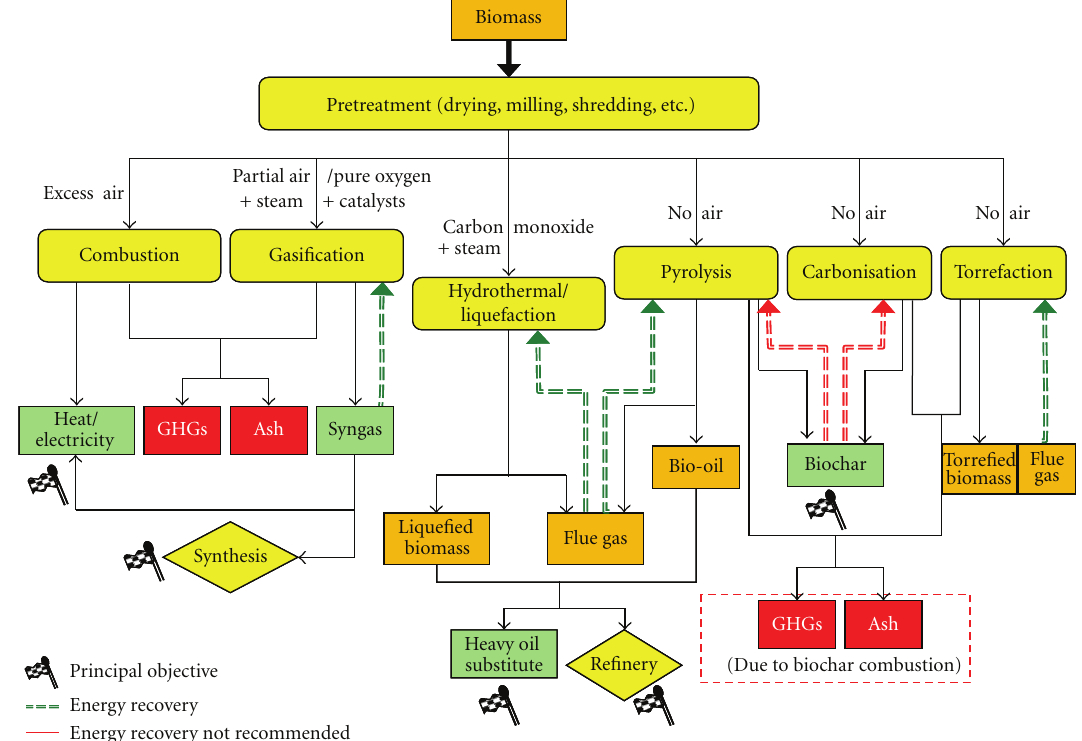
Figure 1: Biomass thermochemical conversion